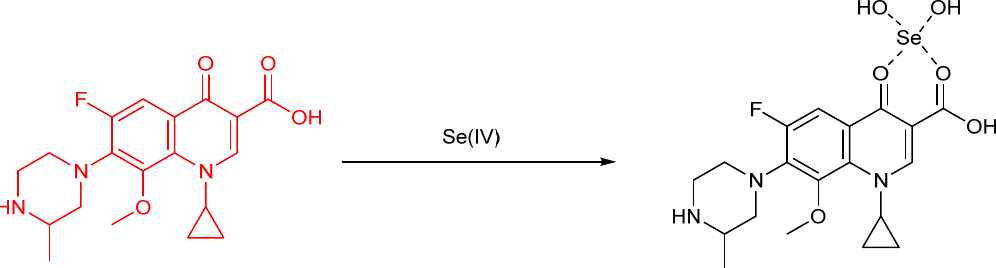
Figure 56. The investigation of GAT as a selective Se(IV) fluorescent probe by Liu et al.